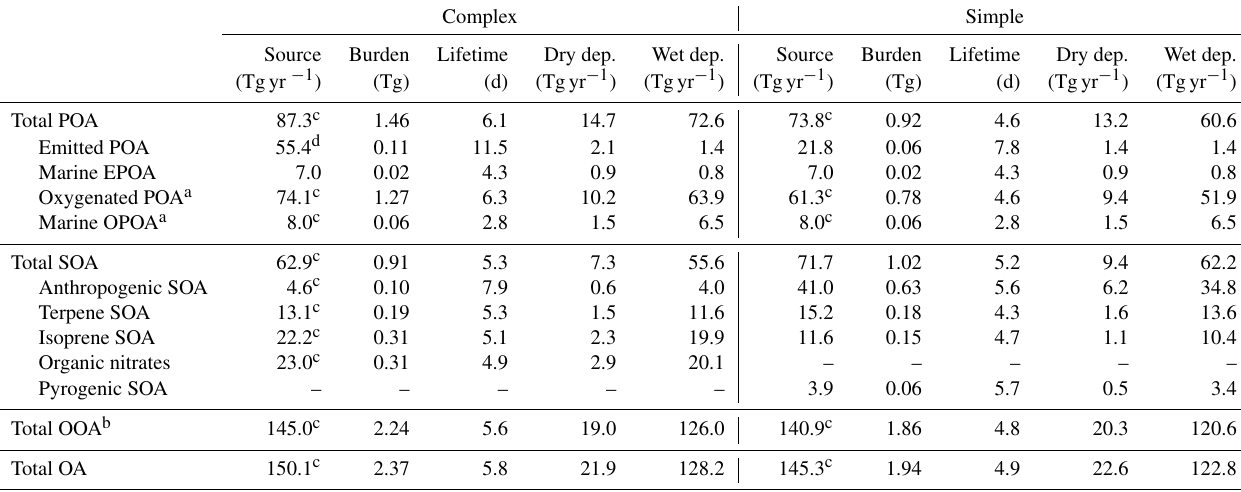
Table 2. Annual mean simulated global source, burden, lifetime (against physical deposition), and wet and dry deposition rates for the individual OA species averaged over 2013 for the complex and simple schemes.